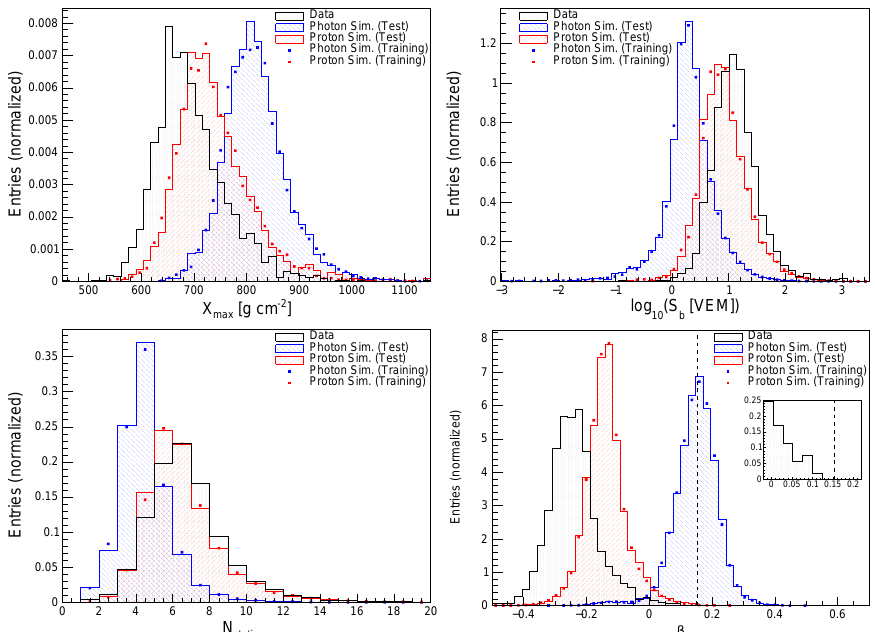
Figure 3. Normalized distributions of the three discriminating observables X max , S b and N stations used in the photon search based on HeCo data. The (simulated) photon sample is shown in blue, the (simulated) proton sample in red, and the data sample in black. In addition, normalized distributions of the final discriminator β —which is based on a MVA combining X max , S b and N stations as well as the photon energy and the zenith angle—are displayed. The dashed line denotes the median of the photon test sample, which is used as the photon candidate cut. In all plots, only events with E γ > 2 × 10 17 eV are shown. For more details, see